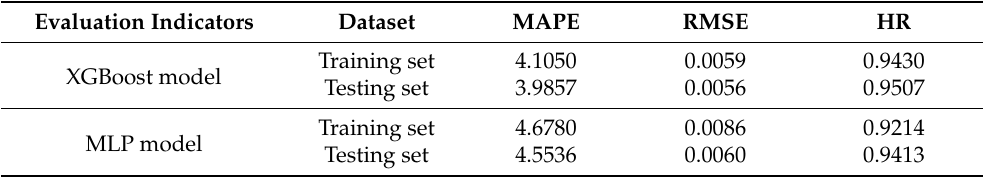
Table 3. Assessment of the predicted results of the two models. Evaluation